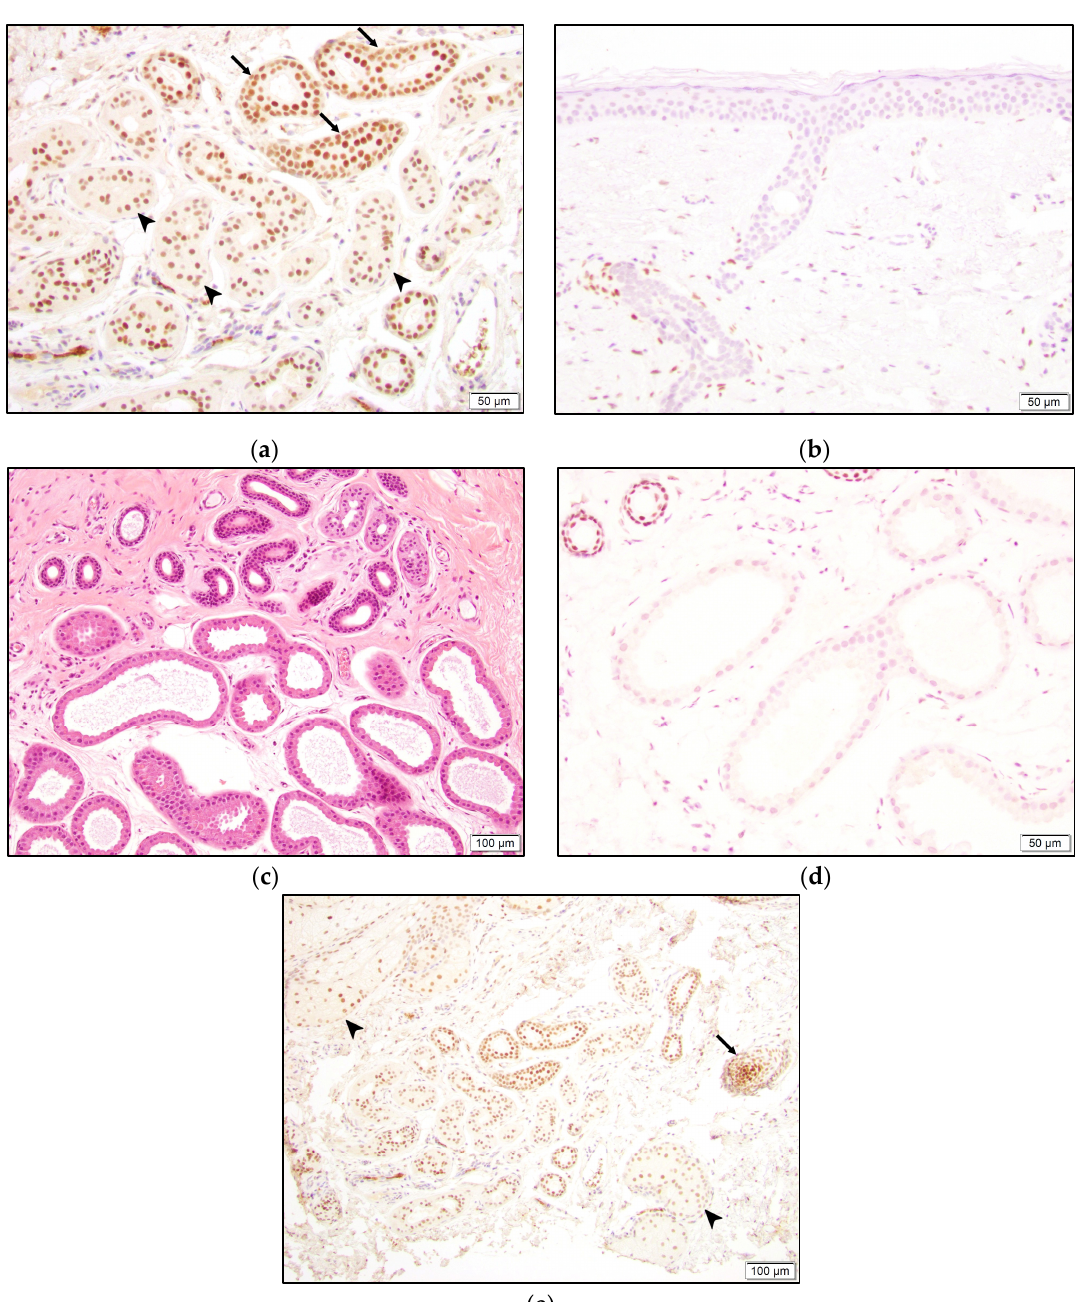
Figure 8. More intense TRPS1 expression in the two eccrine gland sweat duct cell layers (arrow) compared to the inner cell layer of the secretory coil (arrow-head) ( a ). Negative TRPS1 staining in acrosyringium ( b ). Benign apocrine and eccrine glands ( c ) with negative and positive TRPS1 expression, respectively ( d ). TRPS1 positivity in hair follicle bulb with papillary mesenchymal body (arrow) and sebaceous gland (arrow-head) ( e ).